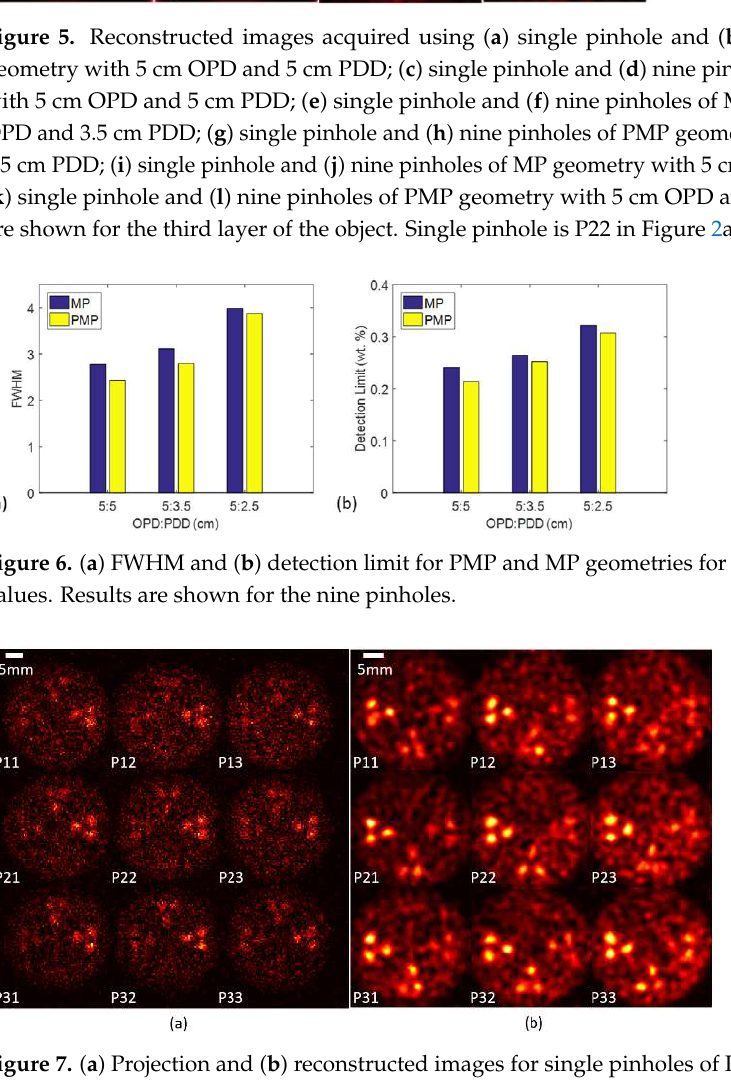
Figure 7. ( a ) Projection and ( b ) reconstructed images for single pinholes of PMP geometry. Figure 8. ( a ) Projection and ( b ) reconstructed images for single pinholes of MP geometry.